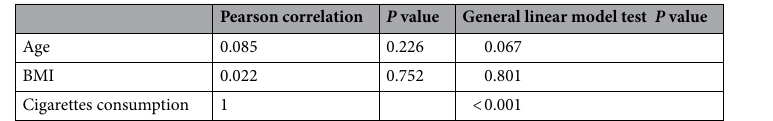
Table 2. Pearson correlation and general linear model test in > 40 years’